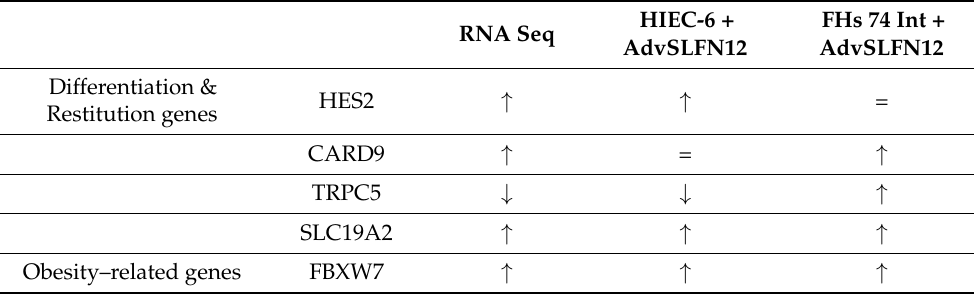
Table 1. Comparison of expression of differentiation, restitution, and obesity-related genes between RNA Seq and HIEC-6 and FHs74 Int in the in vitro